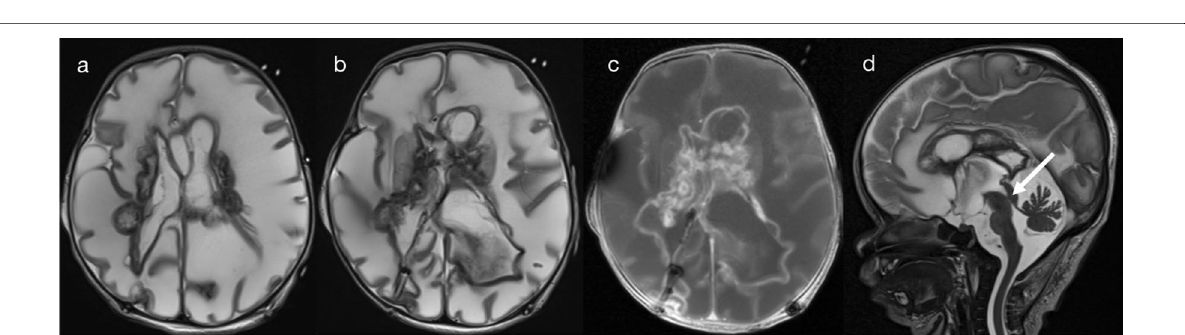
Fig. 11 T2 hyperintensity in supratentorial white matter—with neuronal migration abnormality (Pattern 4A). 2‑week‑old infant with multiple seizures and a bulging anterior fontanelle. CSF analysis was consistent with neurotoxoplasmosis. T2‑weighted images ( a , b , d ) demonstrated diffuse white matter injury, widespread abnormal cortical development and hydrocephalus relating to aqueduct stenosis (arrow). Post‑contrast T1‑weighted imaging ( c ) demonstrated multiple peripherally enhancing lesions in the basal ganglia and periventricular regions, as well as enhancement of the ependymal lining of the lateral ventricles (reflecting ventriculitis)